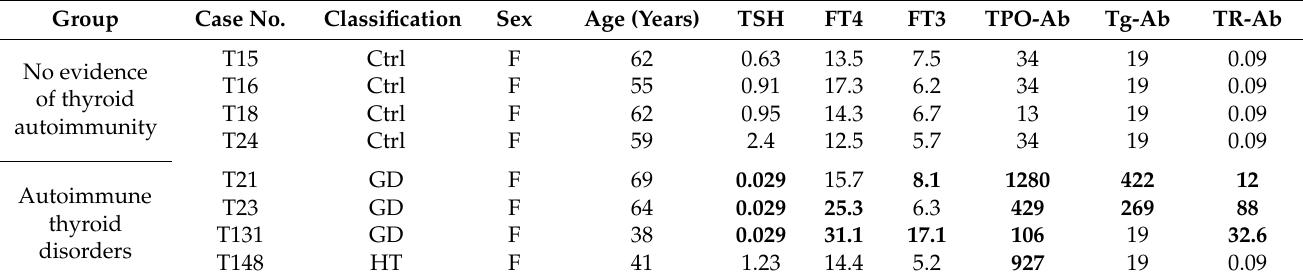
Table 1. Clinical data of AITD cases selected for analysis of RNA transcripts. Out-of-range values are in bold. Group Case